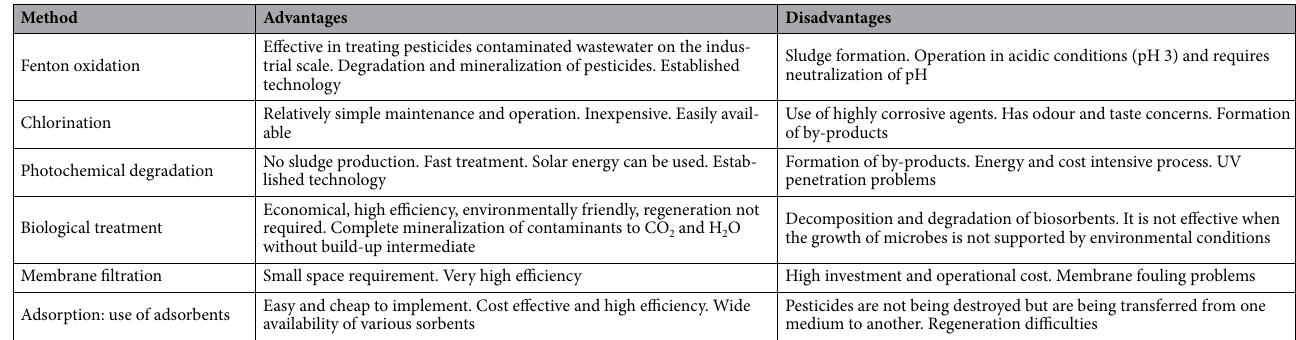
Table 1. The advantages and disadvantages of technologies in the removal of pesticides from